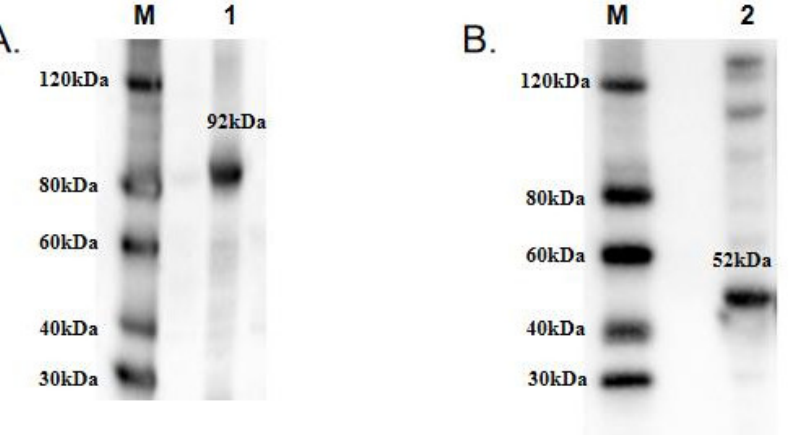
Figure 4. Western blot analysis of recombinant ( A ) TwCDA; ( B ) TwCDA-S. M: protein ladder; 1–2: TwCDA and TwCDA-S fusion proteins. To improve the clarity and conciseness of the pre- sentation, these two gels have been cropped. Original Western blots are shown in Figure S3 (Supplementary